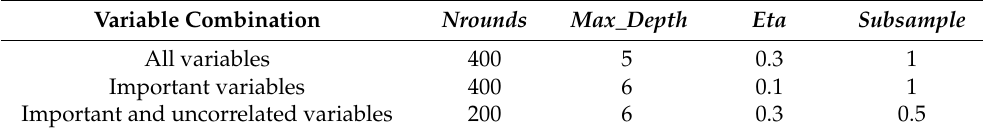
Table 2. Optimal parameters of XGBoost models under three different variable combinations. Variable